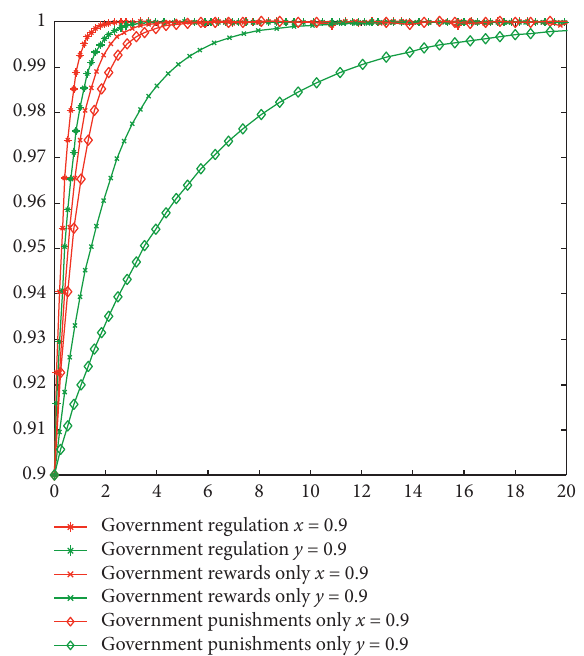
Figure 6: Comparison of convergence speed of government subsidies and punishments on the game between dairy farmers and dairy enterprises.